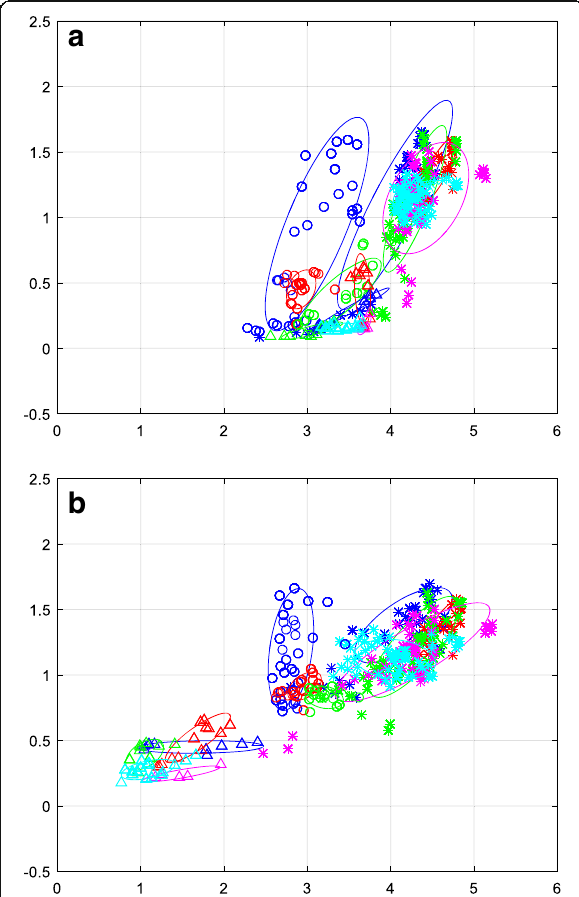
Fig. 6 a , b Stars correspond to the first viseme, circles to the second viseme, and triangles to the third viseme. The color order is blue , red , green , magenta , and cyan for each vowel of viseme. They are corresponding to the vowel order shown in Table